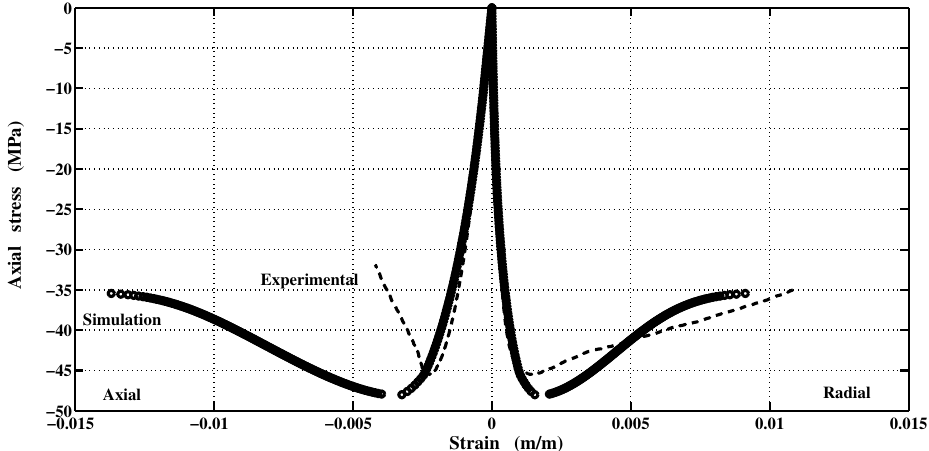
Figure 9. Numerical and experimental stress-strain curve in axial